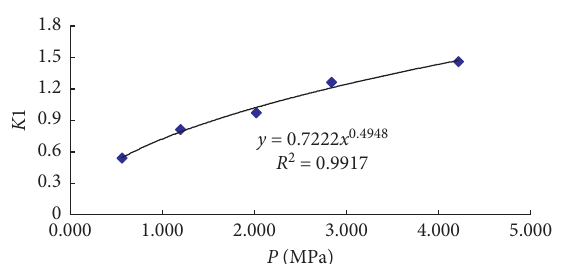
Figure 3: K – P relationship model in the return air roadway in the 1 121901 working face.